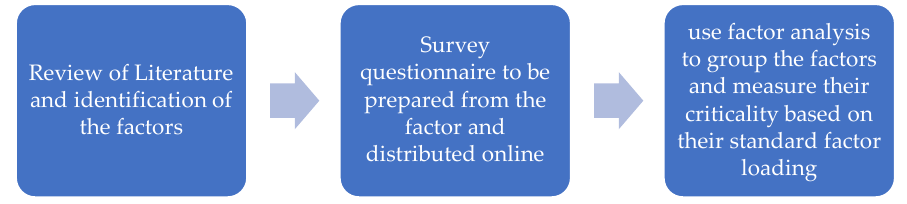
Figure 2. The research approach.